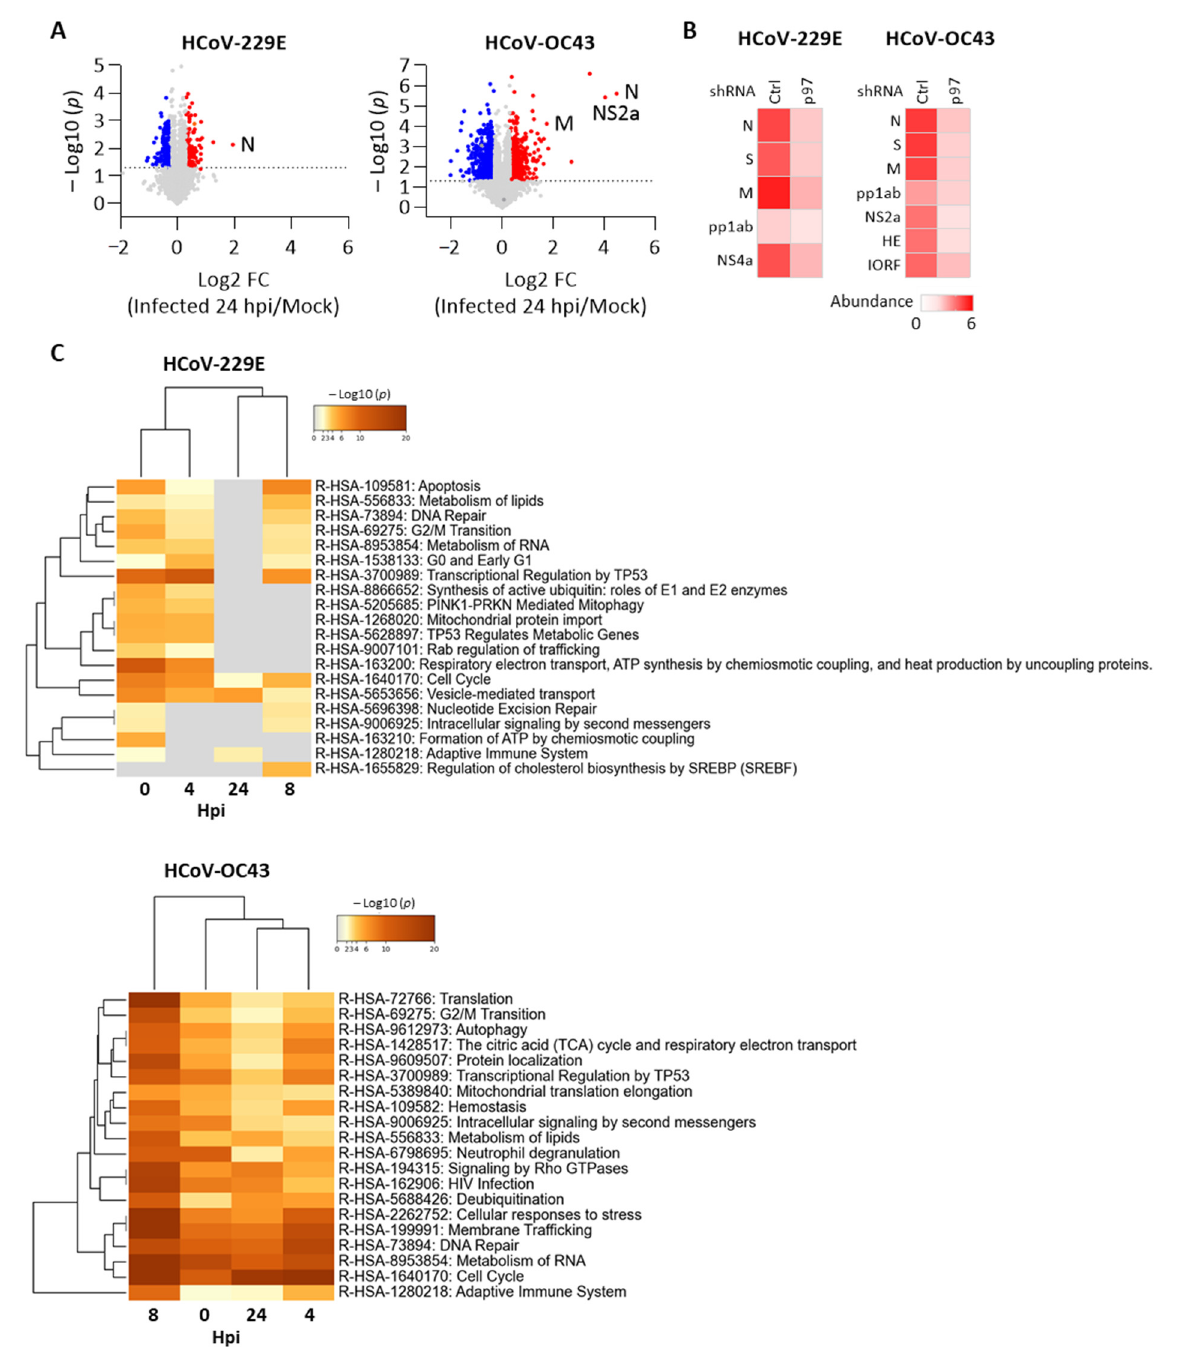
Figure 6. p97 depletion impacts host cell cycle regulators during HCoV infection. Proteomic analysis of H1299 cells with control shRNA (Ctrl shRNA) or p97 shRNA after HCoV-229E or HCoV-OC43 infection. ( A ) Volcano plots of the change in total protein levels comparing HCoV infected cells with control shRNA vs. p97 shRNA at 24 hpi. Up- (red) and down-regulated proteins (blue) with |log2 FC| > 0.3 and –log10 p value > 1.3 are highlighted. Detected viral proteins are labeled. ( B ) Abundance of detected viral proteins in HCoV-infected cells with control or p97 shRNA at 24 hpi. ( C ) Multi-list Reactome enrichment of DEPs (|log2 FC| > 0.3, p < 0.05) between infected cells with control or p97 shRNA at each time point after HCoV-229E or HCoV-OC43 infection. Data presents the top 20 statistically enriched Reactome pathway terms (–log10 p value >